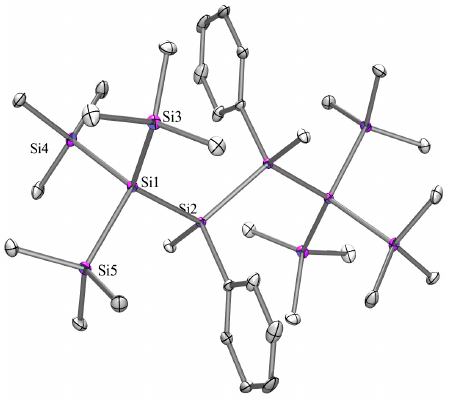
Figure 16. Crystal structure of 18 . Thermal ellipsoids are represented at the 30% level and hydrogen atoms have been omitted for clarity (bond lengths in Å, angles in deg). Si(1)-Si(3) 2.3543(12), Si(1)-Si(4) 2.3592(12), Si(1)-Si(5) 2.3681(13), Si(1)-Si(2) 2.3762(11), Si(2)-C(1) 1.886(3), Si(3)-Si(1)-Si(4) 106.64(4), Si(3)-Si(1)-Si(5) 108.04(4), Si(4)-Si(1)-Si(5) 105.41(5), Si(3)-Si(1)-Si(2) 118.47(4), Si(4)-Si(1)-Si(2) 111.25(4), Si(5)-Si(1)-Si(2) 106.28(4).